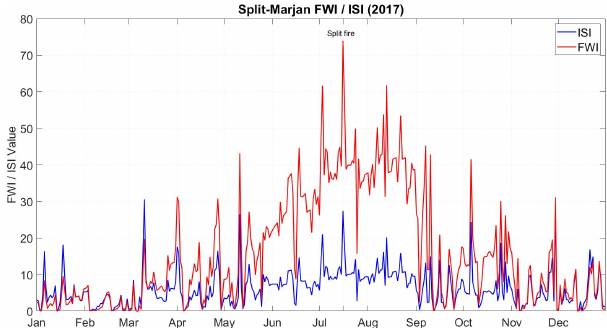
Figure 5. Daily course of initial spread index (ISI) and fire weather index (FWI) at 12:00UTC from 1 January 2017 to 31 Decem- ber 2017 at Split-Marjan meteorological